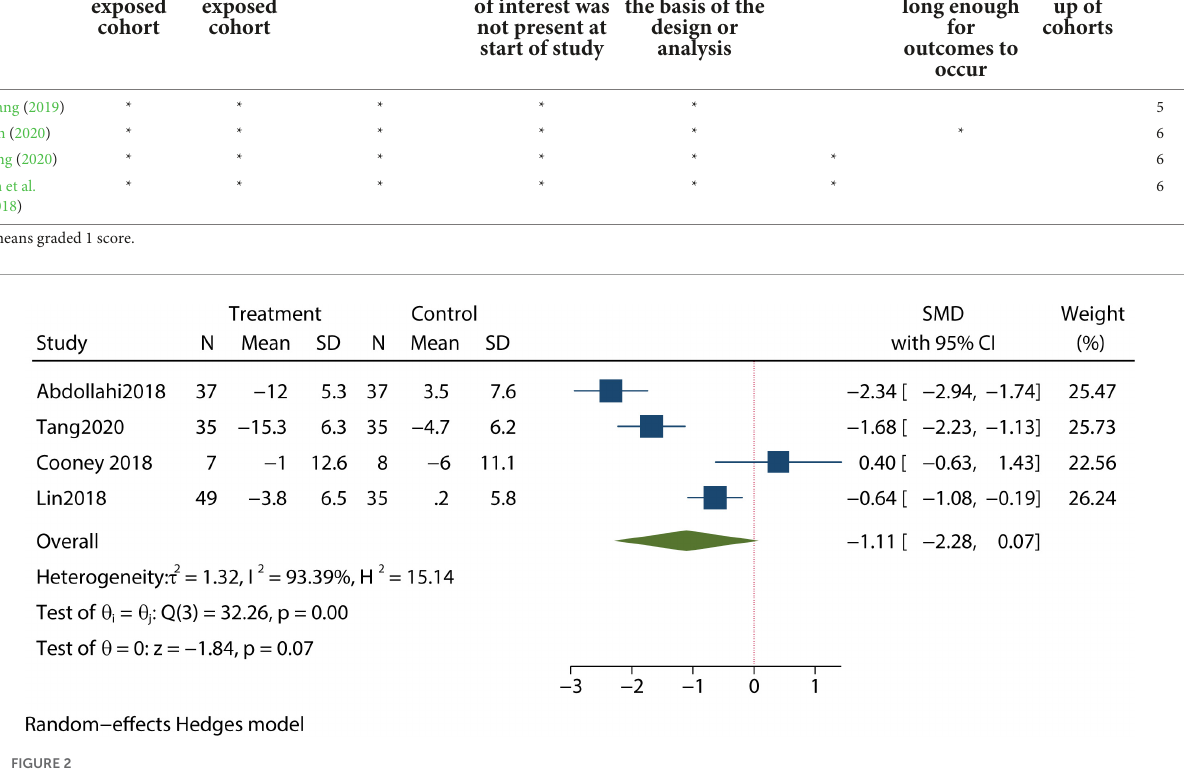
FIGURE2 Meta-analysis of